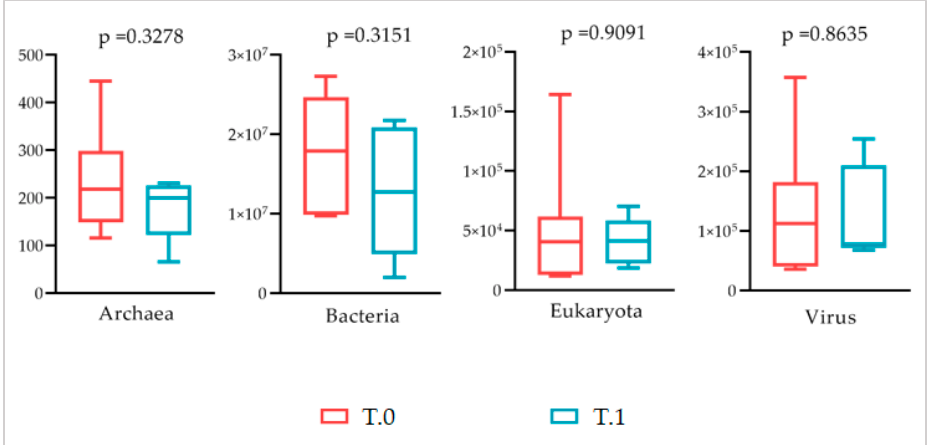
Figure 10. Statistical comparison between the prevalence of principal domains detected in the microbiotas before (T.0) and after (T.1) the LimpiAL treatment (unpaired Student’s t -test and Kolmogorov–Smirnov test, both with p ≤ 0.05) .